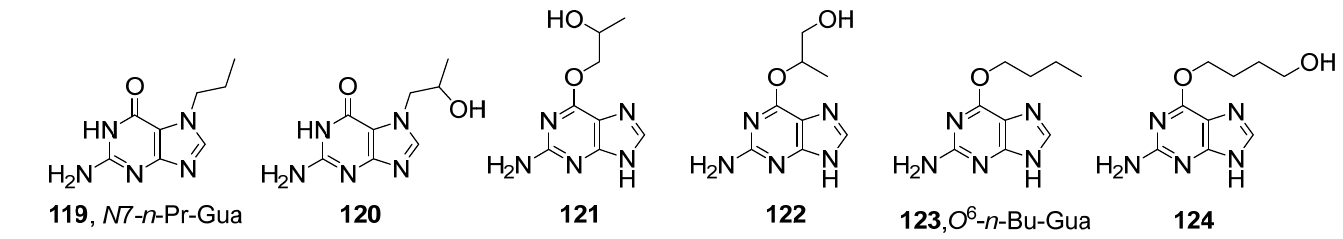
Figure 10. Structures of propyl/hydroxypropyl and butyl/hydroxybutyl DNA adducts.